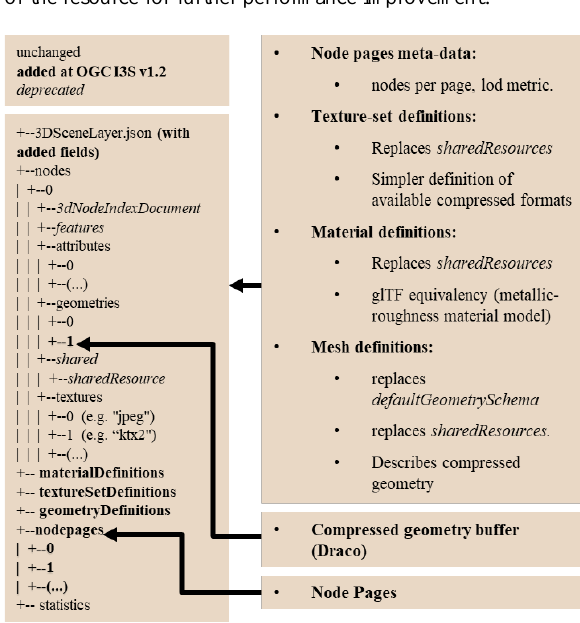
Figure 1 . Figure showing evolution of OGC I3S V1.2.